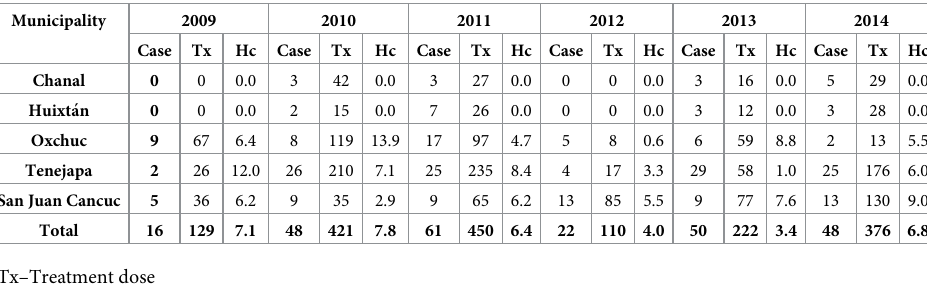
Table 4. Azithromycin doses distributed to trachoma active cases and contacts registered by State Trachoma Pre- vention and Control Program (PEPCT) by endemic municipality, State of Chiapas, 2004–2014. Source: State Pro- gram for the Prevention and Control of